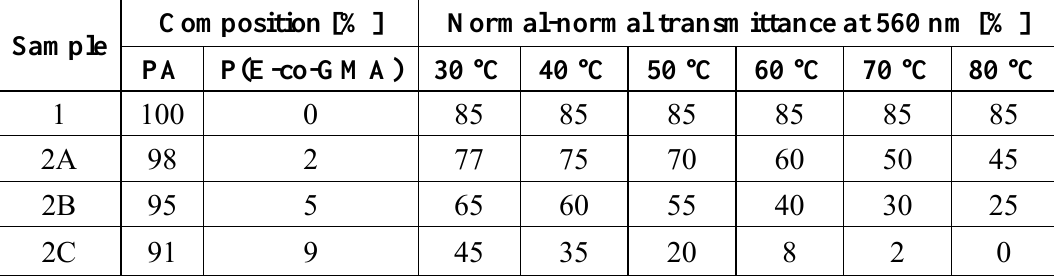
Table 1. Normal-normal transmittance data of PA/P(E-co-GMA) polymer blends [48] with a thickness of 4